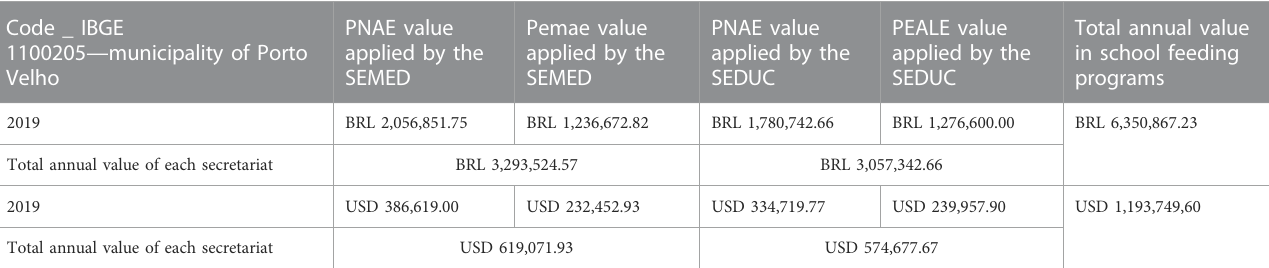
TABLE 4 Investments in family farming products used in school meals made by education secretariats during 2019 — in reais and US dollars — in the PNAE (National School Feeding Program) in the municipality of Porto Velho, State of Rondônia, Brazil. Code _ IBGE 1100205 — municipality of